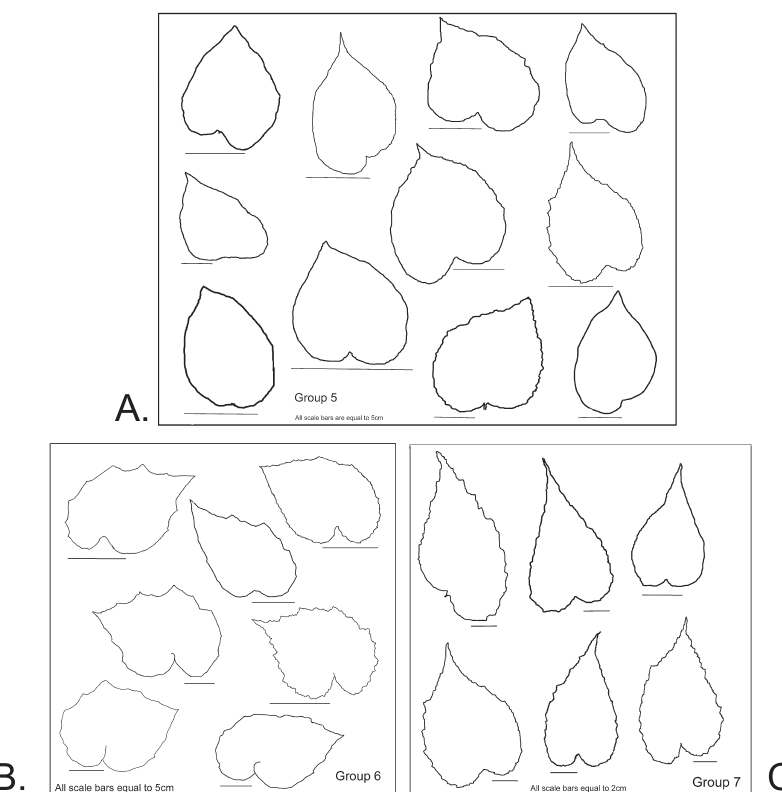
Fig. 4. Leaf tracings. A . Group 5: ovate and symmetric to slightly asymmetric leaves. B . Group 6: ovate, asymmetric and shallow dentate to denticulate leaves. C . Group 7: lanceolate (deltoid) and symmetric leaves.